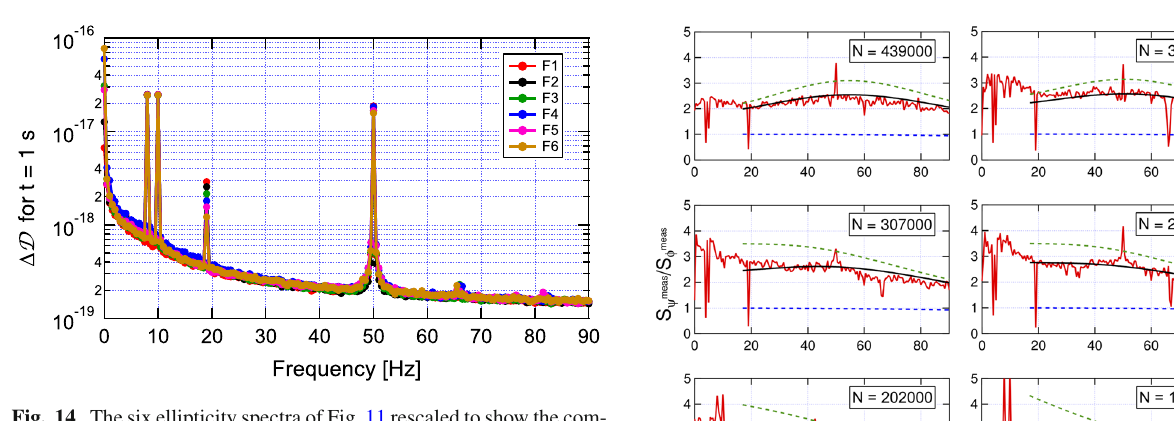
Fig. 14 The six ellipticity spectra of Fig. 11 rescaled to show the com- mon optical path difference sensitivity independent of the number of passes N assuming an ellipticity noise S (cid:8) proportional to N and taking into account the frequency response of the cavity